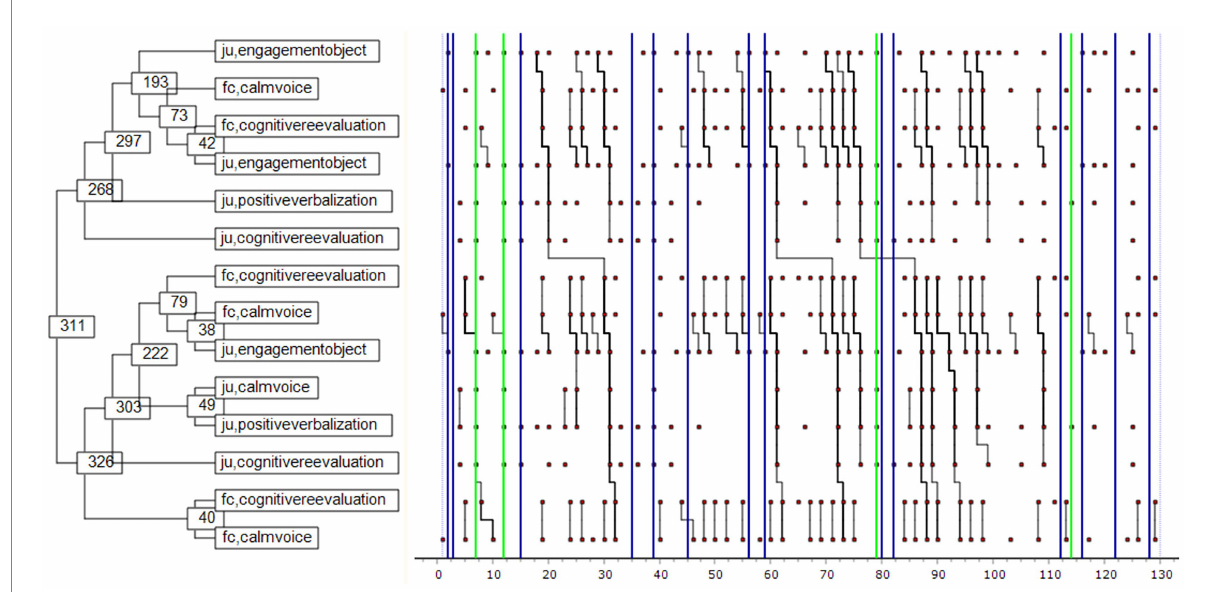
FIGURE 2 Julia-Foster Carer interaction pattern. ju: Julia, fc: foster carer. The X-axis shows the number of behavioral units occurring within the selected 2-min interaction (129 acts overall). Green lines highlight the disengagement behaviors and blue lines are related to self-excitement attitudes. The numbers appearing in the left side of the figure are related to an identification number of each node and is not related with the appearing occurrence of each behavior.